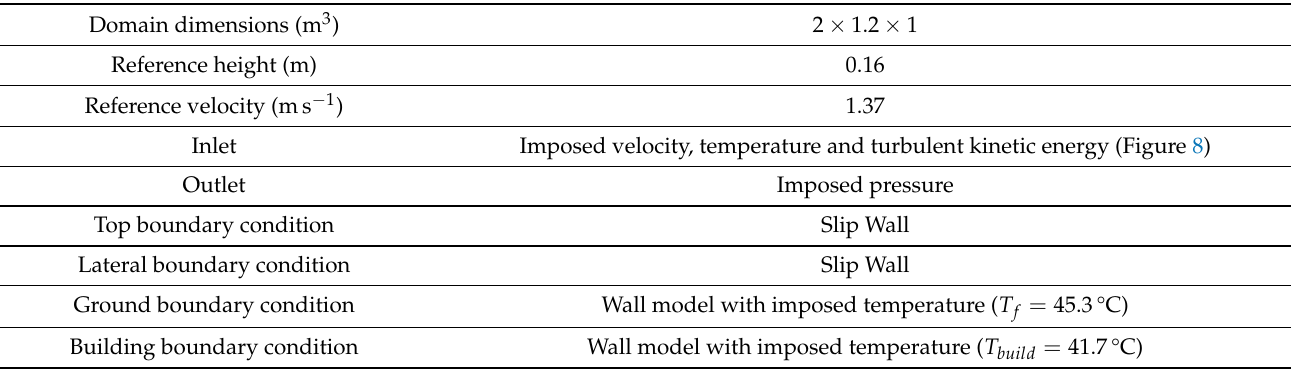
Table 5. Model settings for the isolated building located in an unstable boundary layer